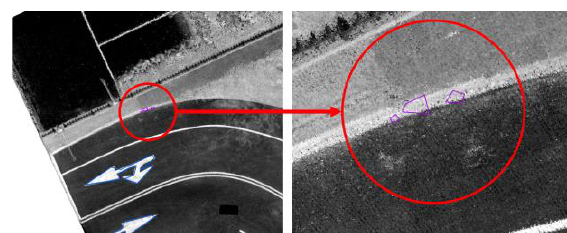
Figure 14. Sample of 3 wrongly detected features.